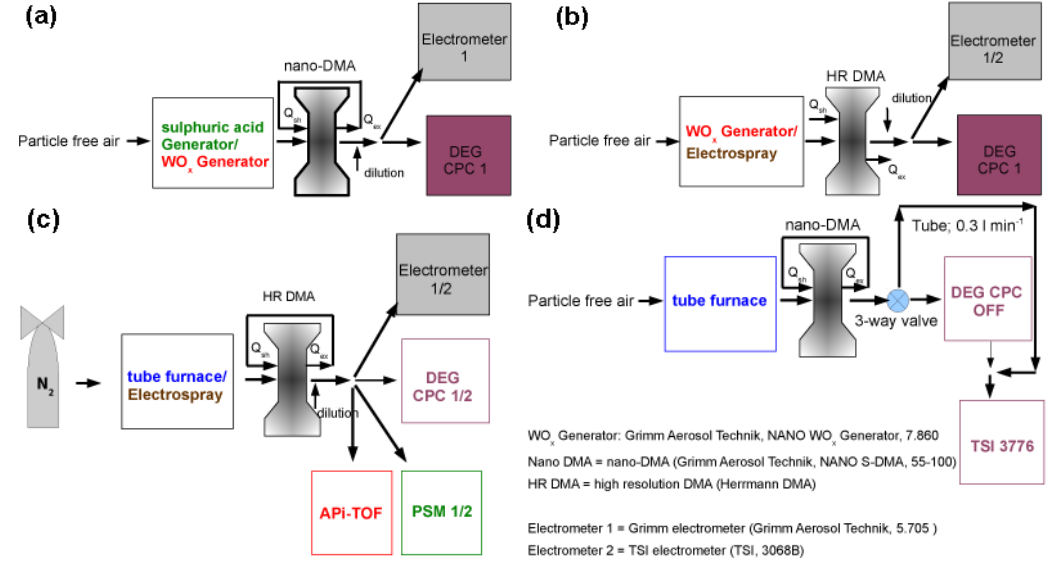
Fig. 3. Overview of the different configurations used for the calibrations. The aerosol generators used together with the nano-DMA are shown in (a) . The measurement configurations using the high-resolution DMA in the open loop mode are shown in (b) and for the closed loop mode in (c) ; (d) shows the setup for quantifying the internal losses of the DEG